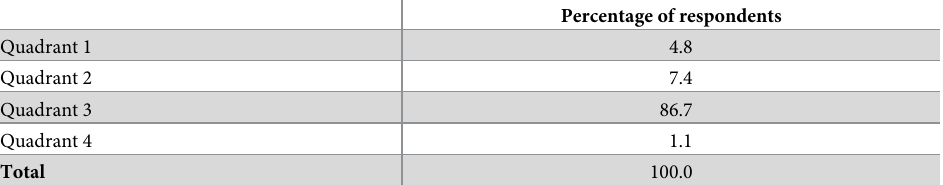
Table 2. I 3 classification for being vaccinated for Covid-19.